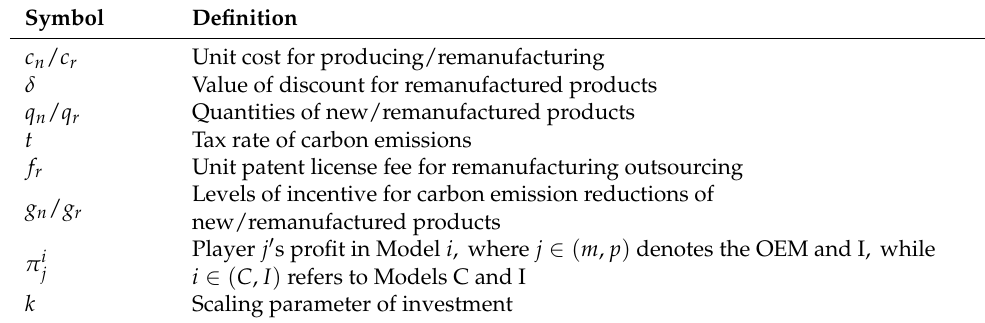
Table 2. Main symbols in this